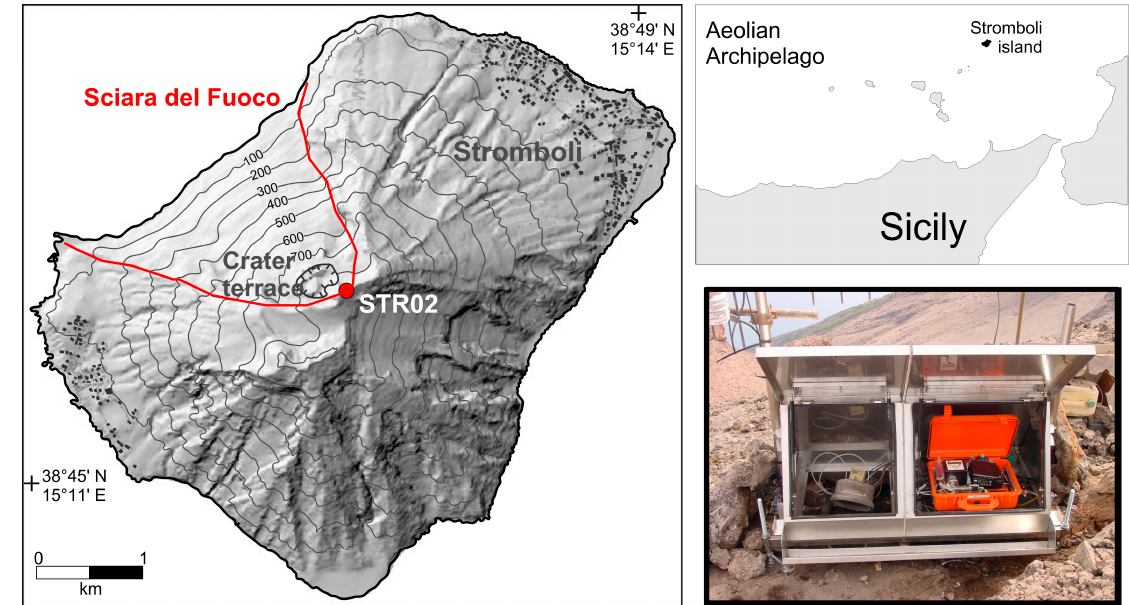
Figure 1. ( a ) Stromboli map with the location of the Stromboli summit area (STR02 station); ( b ) inset of Aeolian archipelago located in the north-east side of the Sicilian coast; ( c ) picture of the STR02 equipment, installed on the summit area (Pizzo sopra La Fossa) of the Stromboli island.